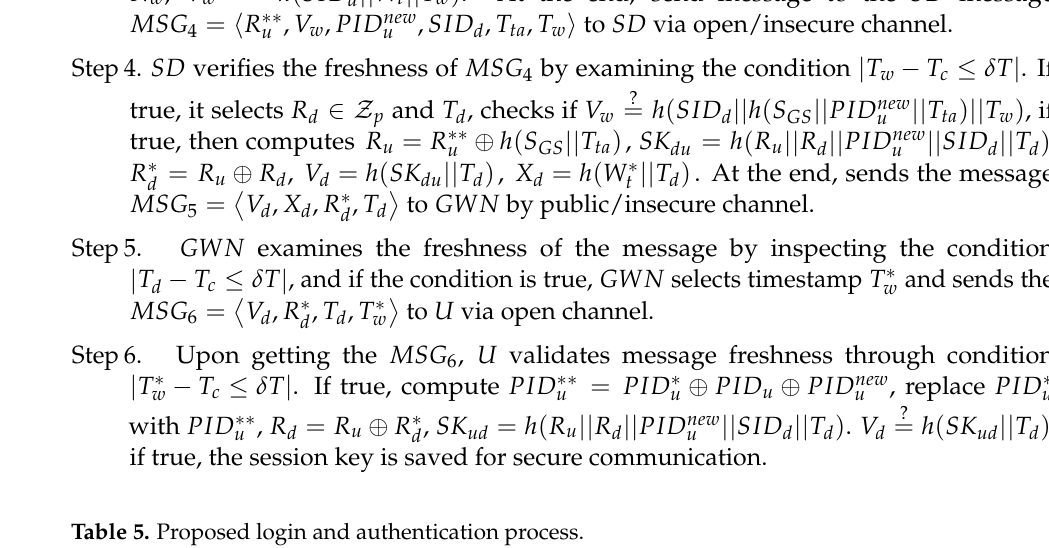
Table 5. Proposed login and authentication